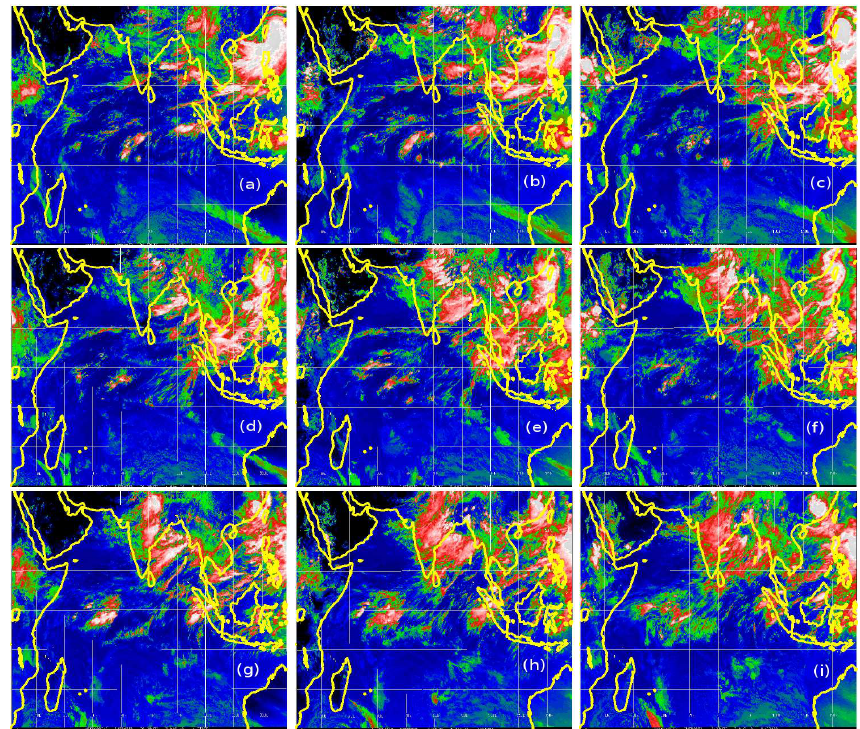
Figure 3. Meteosat-7 image of the clouds during 1 August ( a , b , and c ), 2 August ( d , e , and f ), and 3 August 2012 ( g , h , and i ) at 06:00, 12:00, and